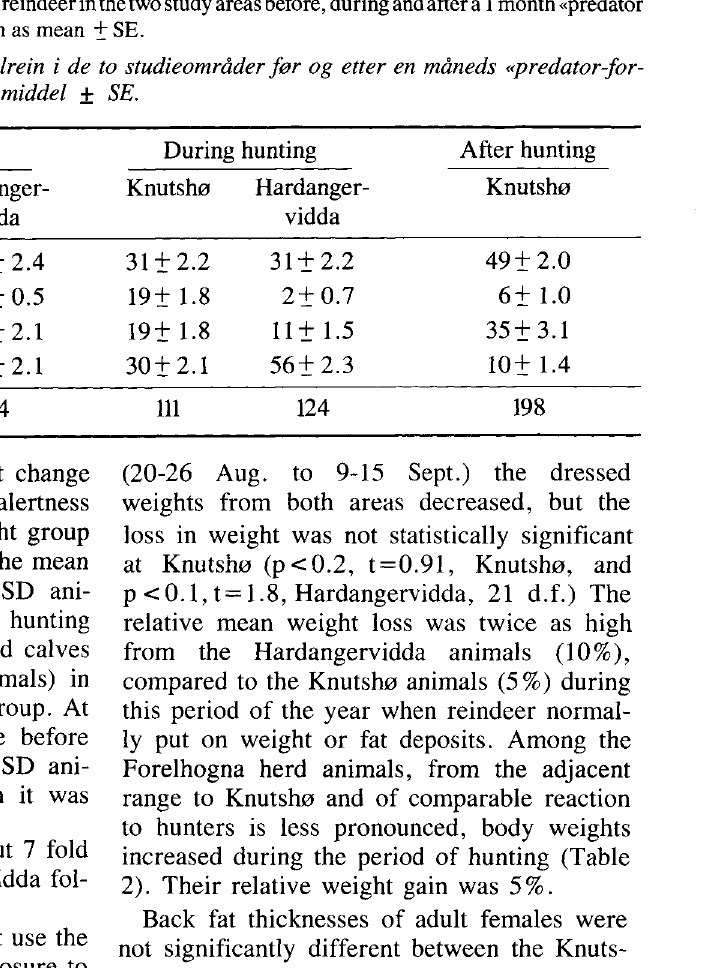
Table 2. Mean + SE dressed body weight of adult first and last period of the annual hunting season. Tabell 2. Middel ± SE slaktevekt av voksne ( > 3 år) reinsimler samlet gjennom første